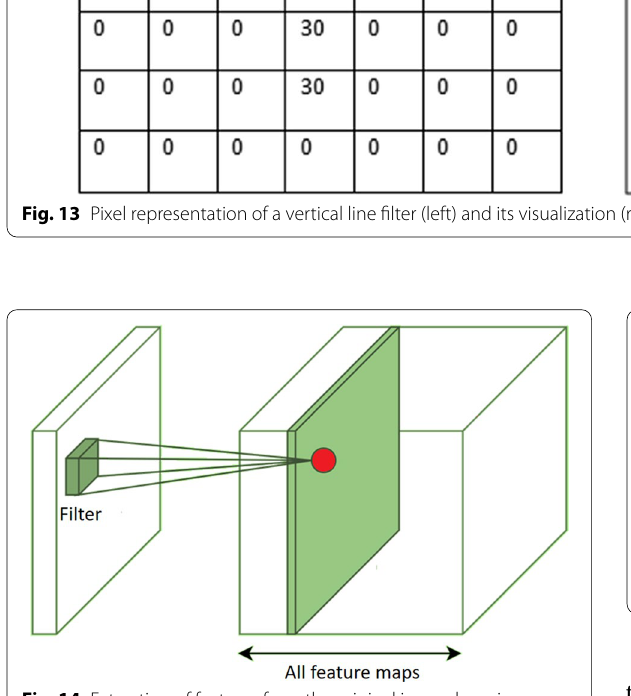
Fig. 14 Extraction of features from the original image by using sliding filters